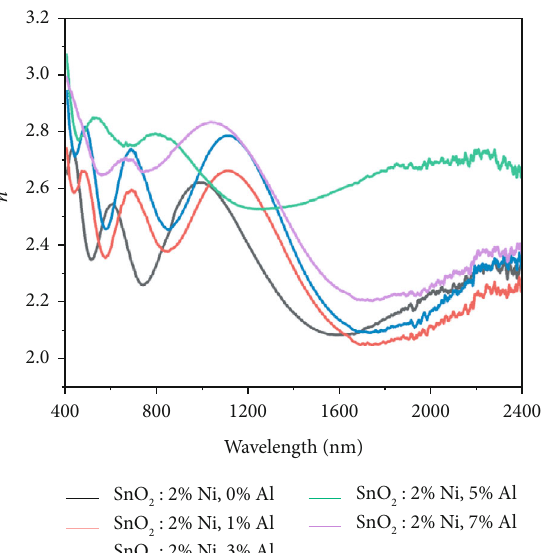
Figure 11: Imaginary part of dielectric constant of Al-Ni-codoped thin fi SnO 2